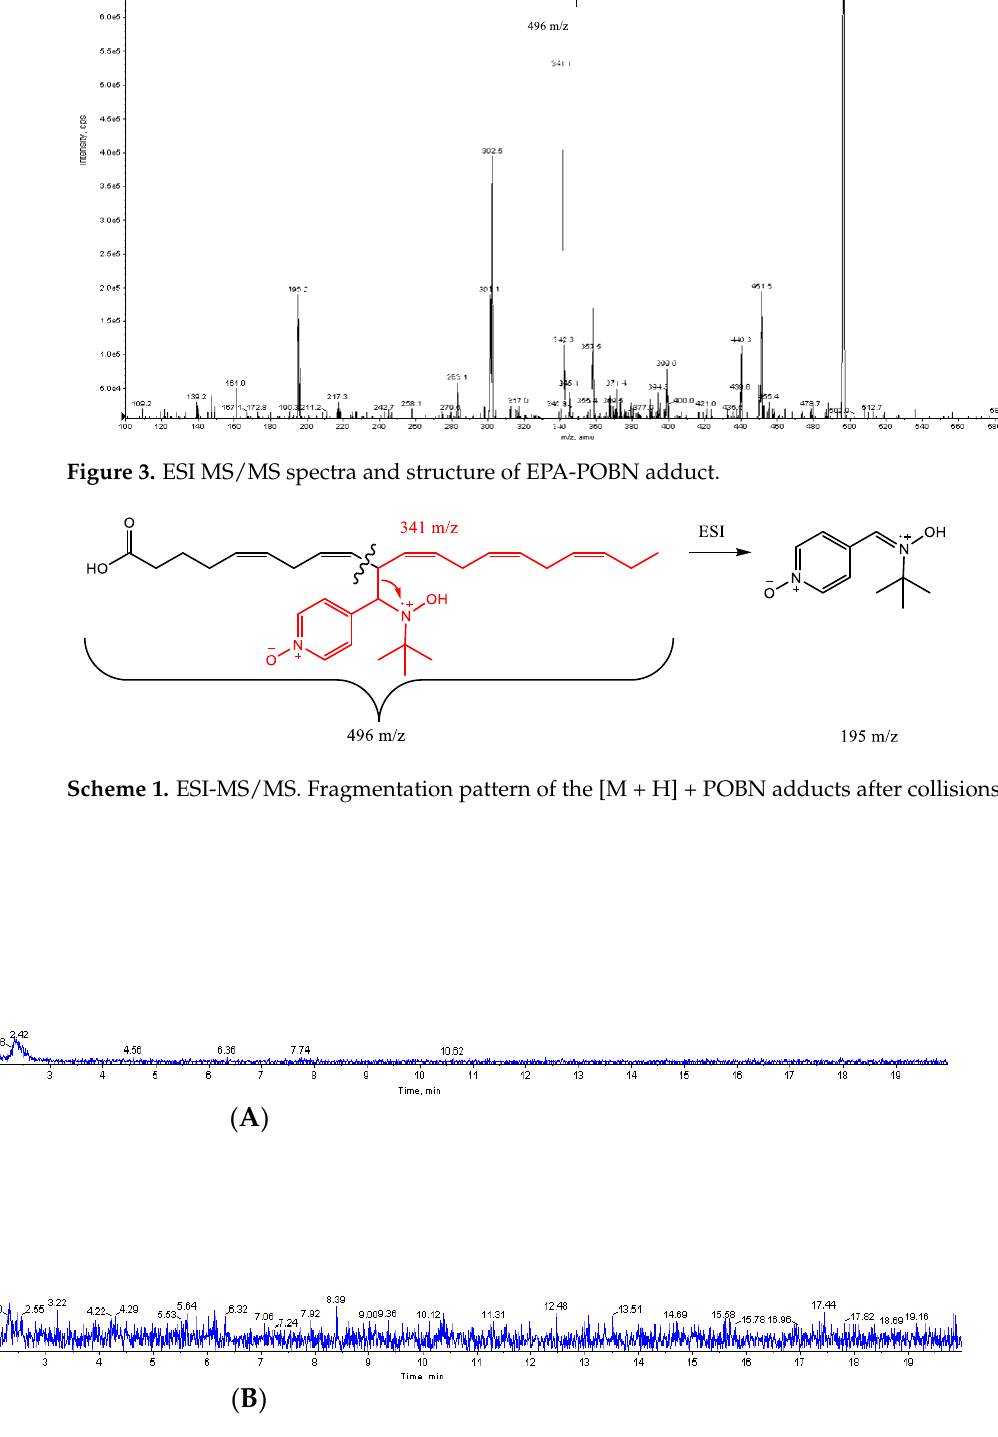
Figure 3. ESI MS/MS spectra and structure of EPA-POBN adduct.